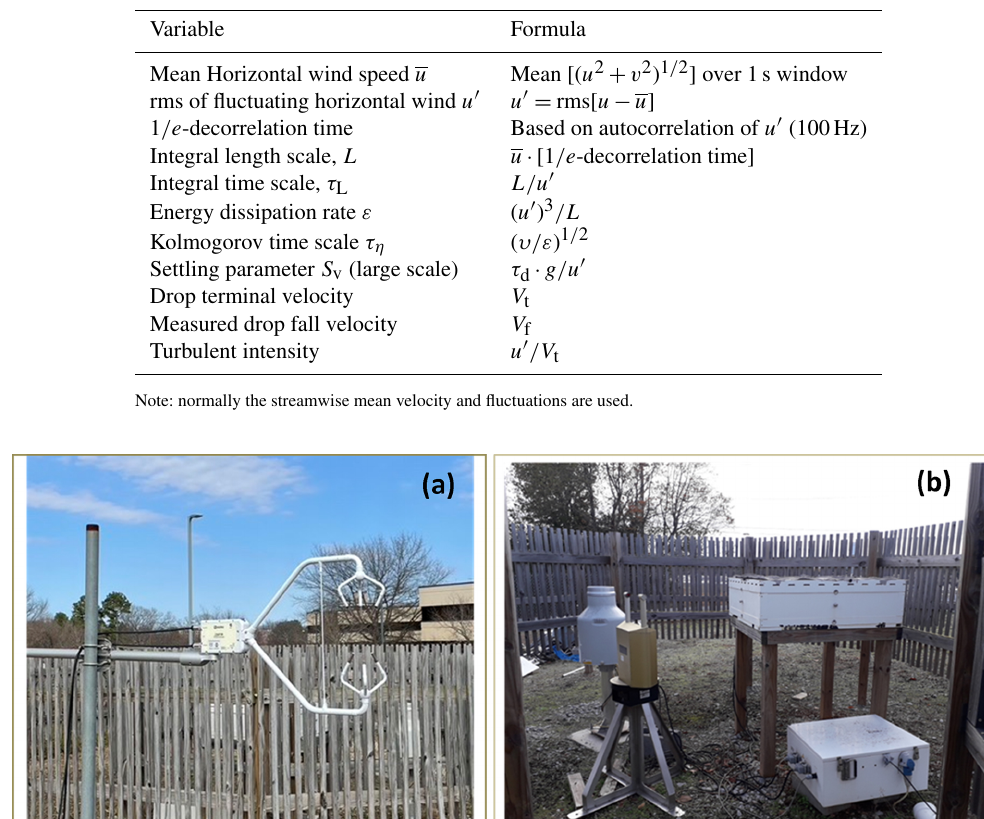
Table 1. Formulas for estimating the relevant quantities.